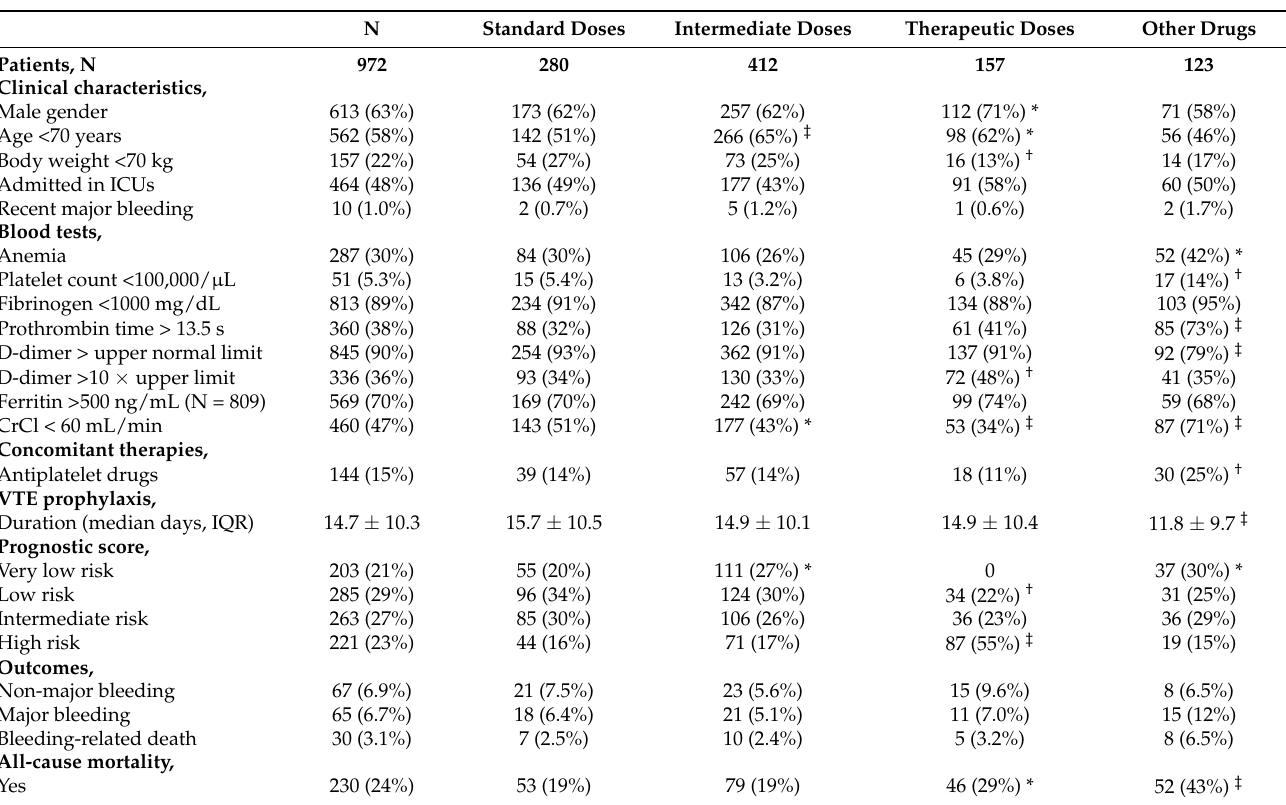
Table 1. Clinical characteristics of the patients, according to the use of different doses for VTE prophylaxis. N